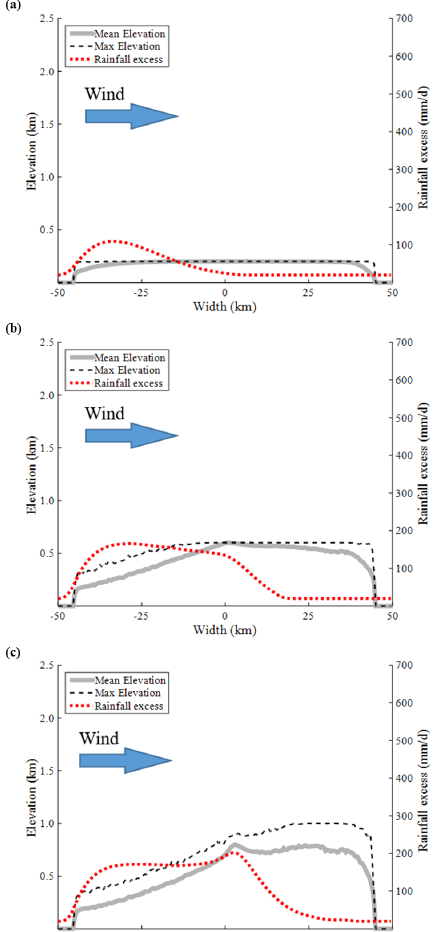
Figure 4. Transects of evolving landscapes and rainfall field from a co-evolution simulation after (a) 0.2, (b) 0.6, and (c) 1Ma of sim- ulation times. Simulation is implemented with V = 16ms − 1 and t d = 1200s. The results at 5Ma are shown in Figs. 2, 3b, and